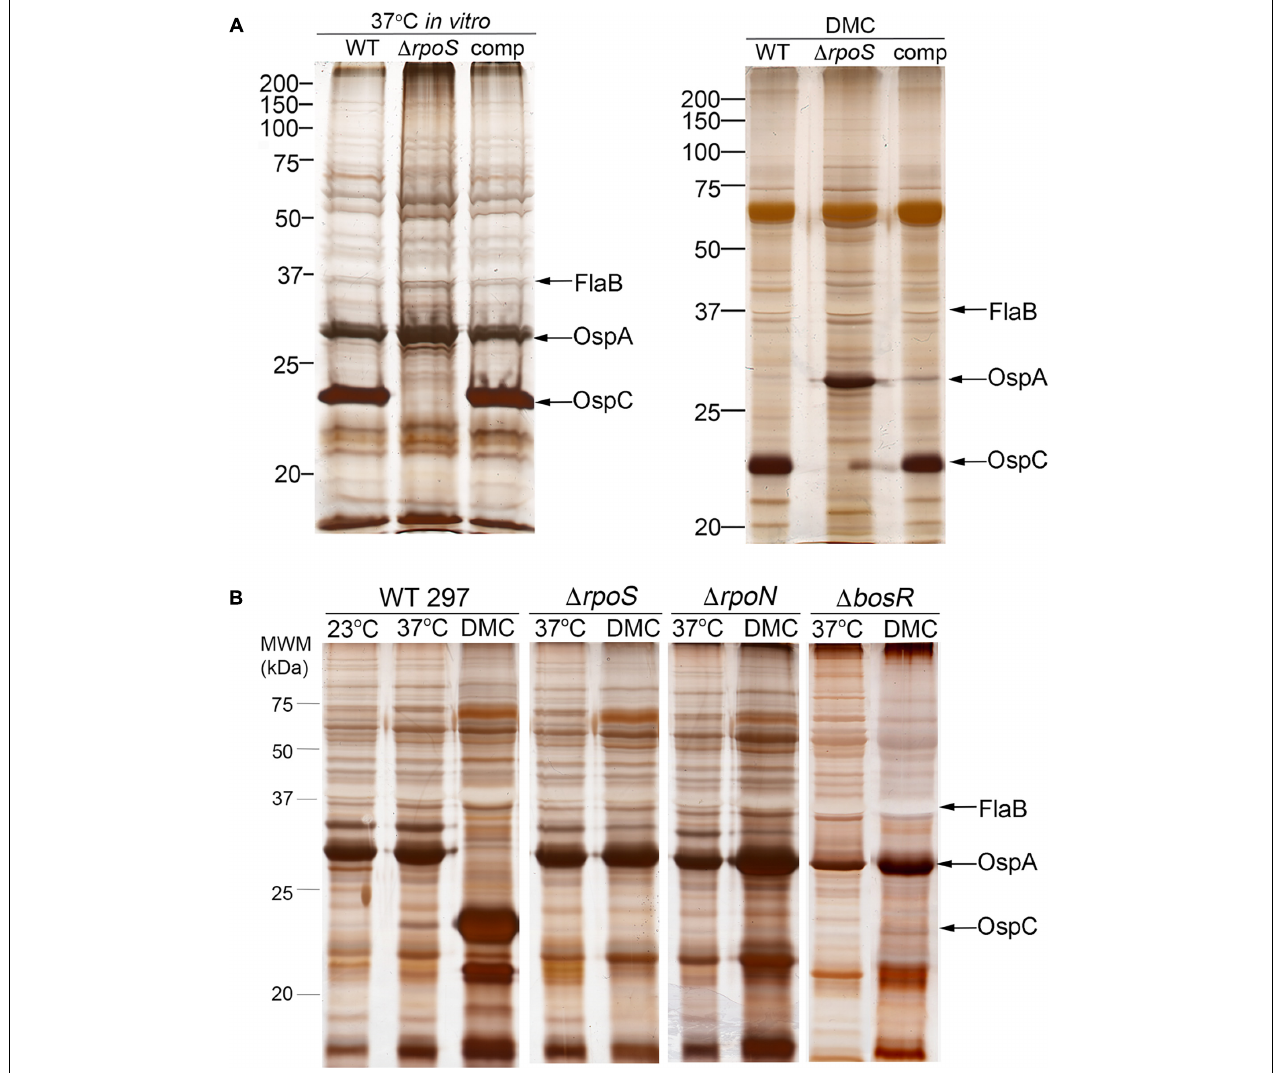
FIGURE 4 | Reciprocal regulation of OspC and OspA by RpoS occurs only within mammals and requires an intact RpoN/RpoS pathway. (A) Whole-cell lysates from wild-type strain B31 5A4 (WT; BbP1781), isogenic (cid:49) rpoS mutant (BbP1752) and complemented mutant (comp; BbP1754) strains following temperature-shift in vitro and cultivation in DMCs separated by SDS-PAGE and stained with silver. (B) Whole cell lysates of wild-type strain 297 and isogenic (cid:49) rpoS , (cid:49) rpoN, and (cid:49) bosR mutants following temperature-shift from 23 to 37 ◦ C in vitro and cultivation in DMCs. Molecular weight markers (kDa) are shown at the left of each